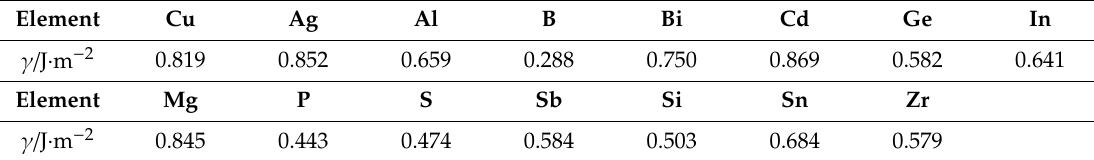
Table 6. E ff ects of alloying elements on interfacial energies of Cu / γ –Fe interface. Element